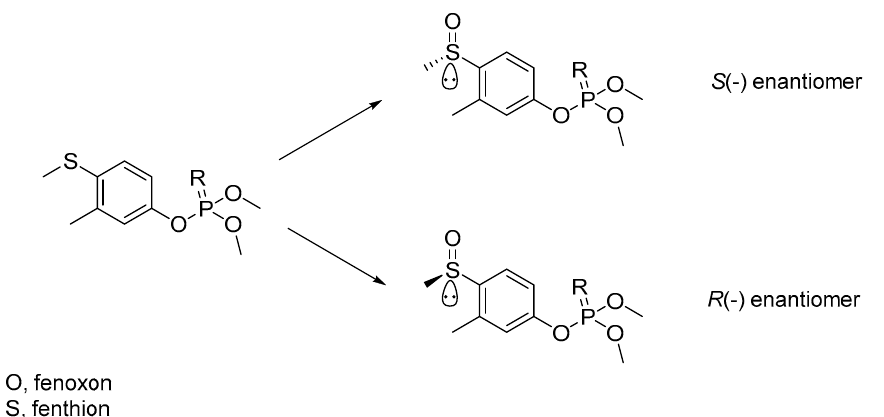
Figure 4. Fenthion and fenoxon oxidation and enantiomers generation on chiral sulfur.